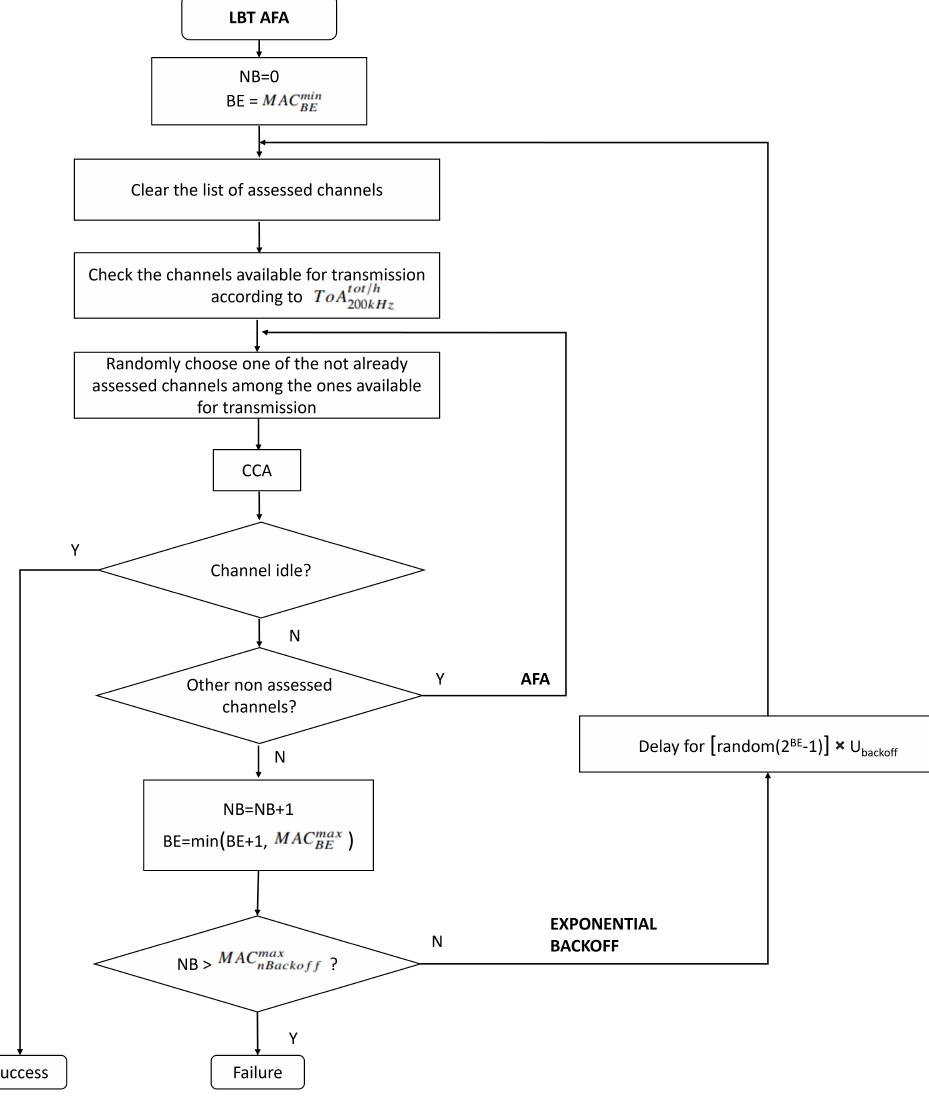
Figure 4. LBT AFA operation